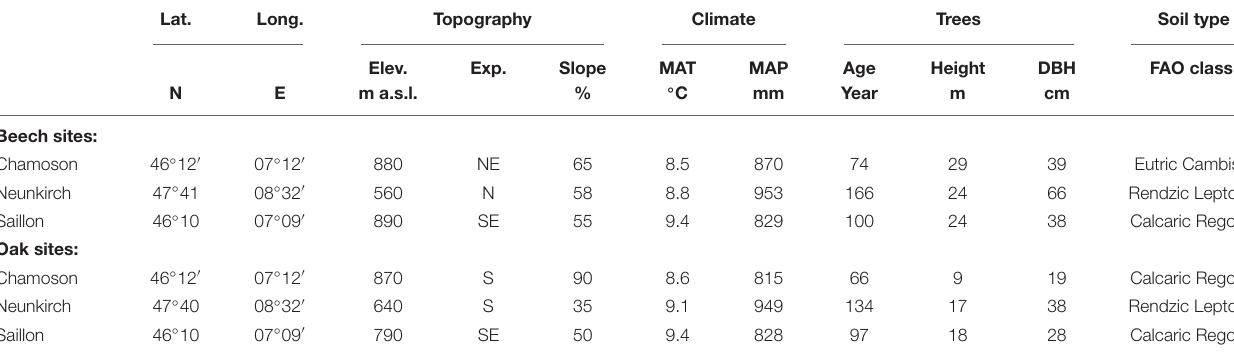
TABLE 1 | Forest site, tree and soil characteristics.